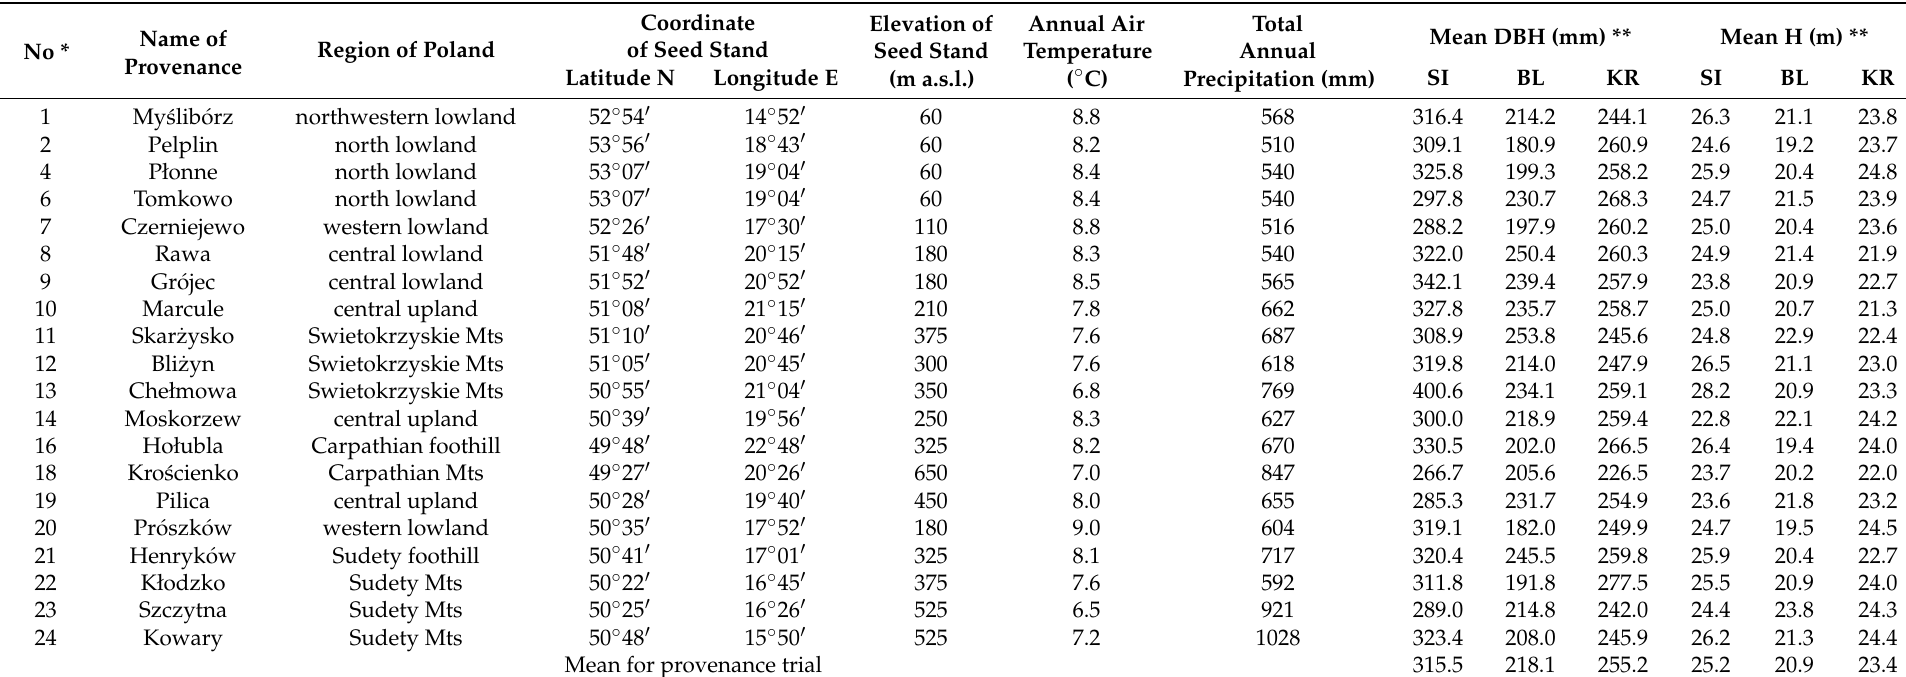
Table 2. Location and climate parameters of seed source stands and dendrometric statistics of the studied larch provenances growing during the provenance trials in Siemianice (SI), Bli˙zyn (BL) and Krynica (KR)